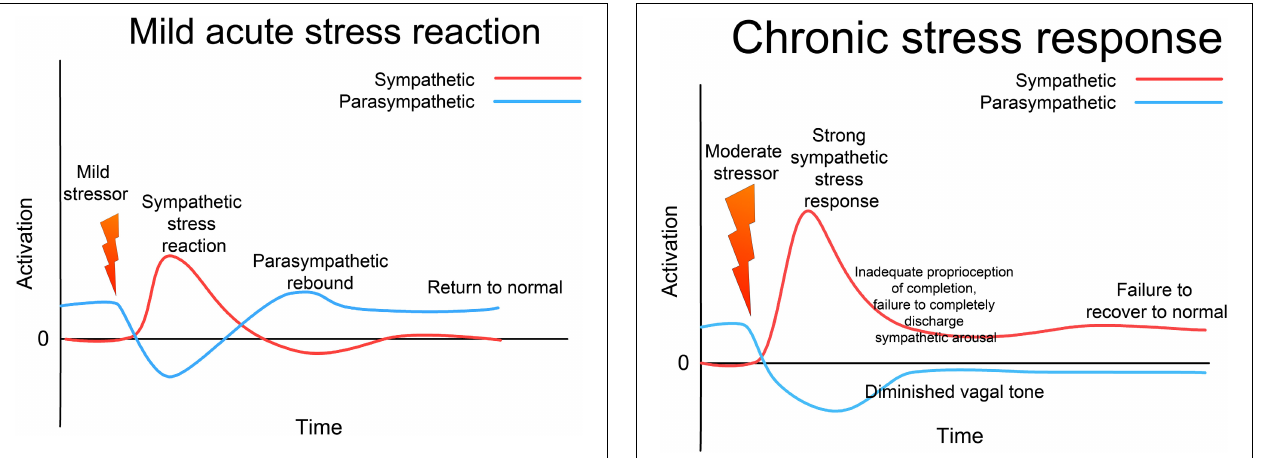
FIGURE 4 | Chronic stress response. If the stressor is above a certain intensity or duration, the sympathetic response is more intense; if there is an inadequate defensive response, the system as a whole may fail to reset to normal functioning, remaining “tuned” to excess sympathetic and deficient parasympathetic activation. This state may persist indefinitely, giving rise to a state of “chronic stress,” where the system responds inappropriately to environmental challenge with excess activation. Note that this is not “allostatic wear and tear,” but an altered (dys-)functional state; such a chronic state is a major contributor to allostatic over-load. Through appropriate intervention, the system can be returned to a normalized, fully functional state; but without such intervention the dysfunctional state may last